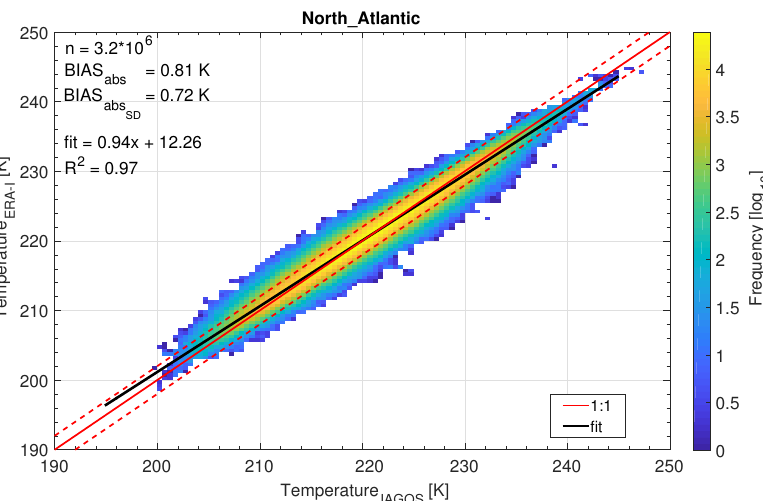
Figure 9. Temperature correlation from the observations and ERA-I over the North Atlantic region. The distribution is averaged in bin widths of 0.5K and the color shows the number frequency with each bin on a logarithmic scale. The numbers included show the number of data points, the absolute bias, the corresponding SD, and the linear robust regression fit (black line). The 1 : 1 line is shown in red, and its variation with 2K is shown as dashed red lines. The statistical values for all other regions are summarized in Table